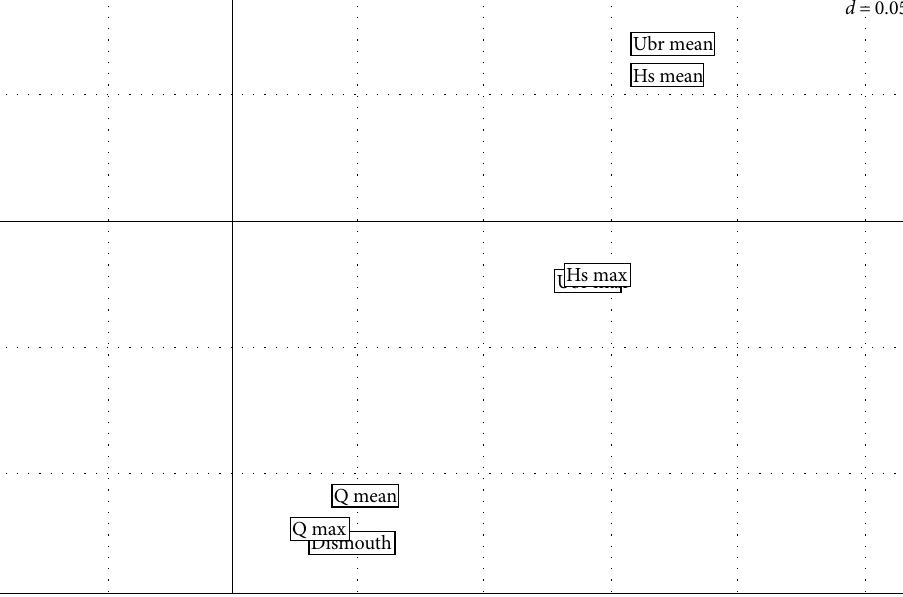
Figure 5: RLQ diagram as defined by the two axes with the projection of different environmental variables with an influence on the faunal distribution (i.e. results of DISTLM). The 𝑑 value in the upper right corner is the scale of the graph given by a grid.